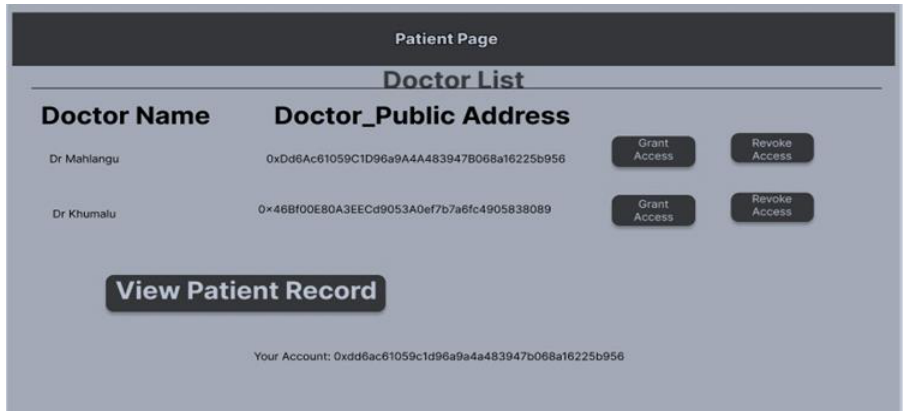
Figure 10. Grant or revoke feature.